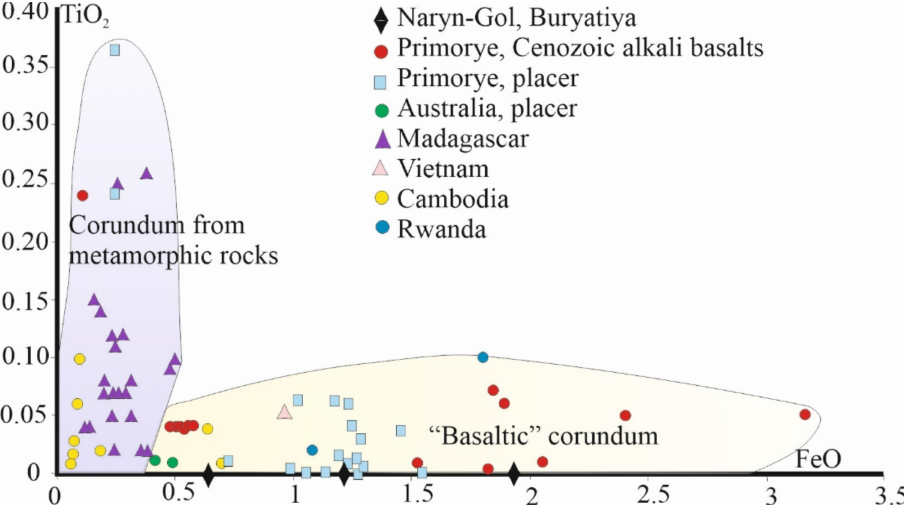
Figure 13. The difference between sapphires of various genesis in respect of the content of titanium and iron (wt. % oxides) . Adapted with permission from [6]; Primorye, Cenozoic alkali basalts [6]; Pri- morye, placer [6]; Australia, placer [27–30]; Madagascar [31–33]; Vietnam [34]; Cambodia [27,35,36]; and Rwanda [37]. Naryn-Gol—this